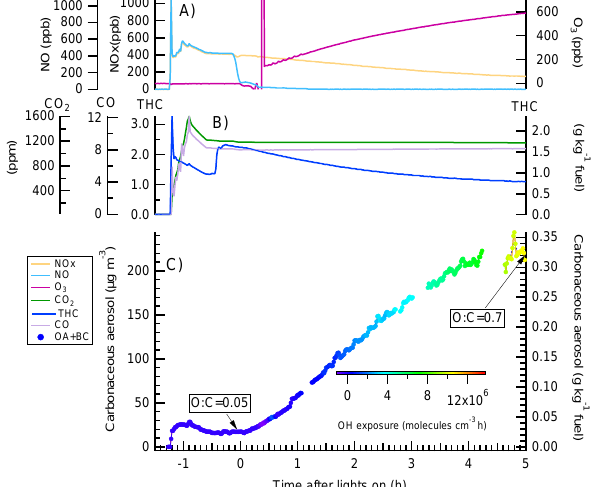
Fig. 5. Measured concentrations and calculated emissions factors (EFs) inside the mobile smog chamber of gas and particle phase species after injection of emissions from a Euro 5 gasoline light- duty vehicle (GLDV) (Exp. 2) as a function of time after lights-on in the chamber. (A) NO x (yellow), NO (light blue), O 3 (magenta). Af- ter an initial spike due to sample injection, a small decrease in NO x before lights-on follows the injection of additional air required to completely fill the chamber. O 3 increases after lights-on as a con- sequence of the photochemical processing of emissions occurring inside the chamber. Temperature is stable to within 1 ◦ C throughout the experiment. (B) Carbonaceous gases. After an initial decrease due to the dilution, CO 2 (green) and CO (lilac) concentrations are constant indicating that the system is airtight. The increase in total hydrocarbon (blue) before lights-on follows the addition of propene required to adjust the VOC/NO x ratio. (C) Wall loss corrected car- bonaceous aerosol (black carbon, BC+organic aerosol, OA) in- creases after lights-on due to secondary organic aerosol (SOA) for- mation. OH exposure is shown by the colour scale. Aging increases the O:C ratio of the emissions from 0.05 for the primary to 0.7 for the secondary, a ratio equivalent to the low volatility oxidised OA observed in highly aged ambient aerosols. The right axis in (B) and (C) shows the EF calculated for THC and carbonaceous aerosol using Eqs. (6) and (7).